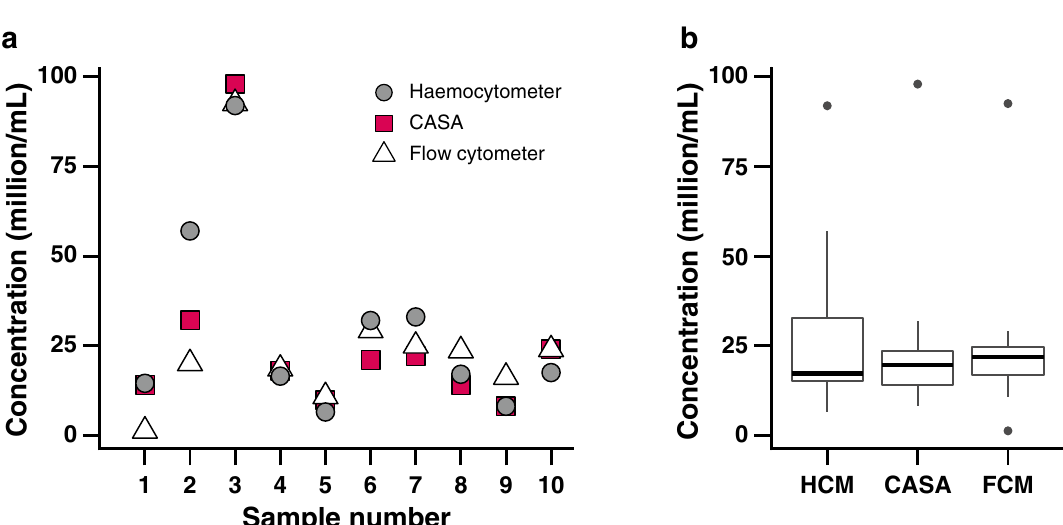
Figure 4. Computer-assisted sperm analysis (CASA) assessment of total ( a ) and motile ( b ) sperm concentrations in samples from Lobactis scutaria (n = 20), Montipora capitata (n = 9), and Montipora flabellata (n = 15) in the presence of filtered seawater (FSW) and filtered seawater with bovine serum albumen (FSW + BSA). Data are presented as mean ± SE, and in each panel ( a and b ), columns with the same letter are not significantly different ( P < 0.05).